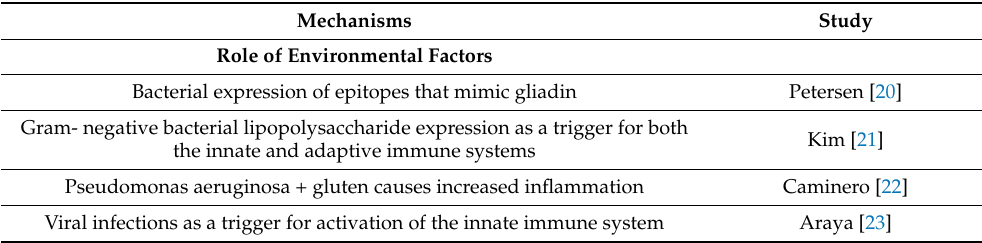
Table 1. Summary of the mechanisms by which the gut microbiota may participate in the pathogenesis of celiac disease